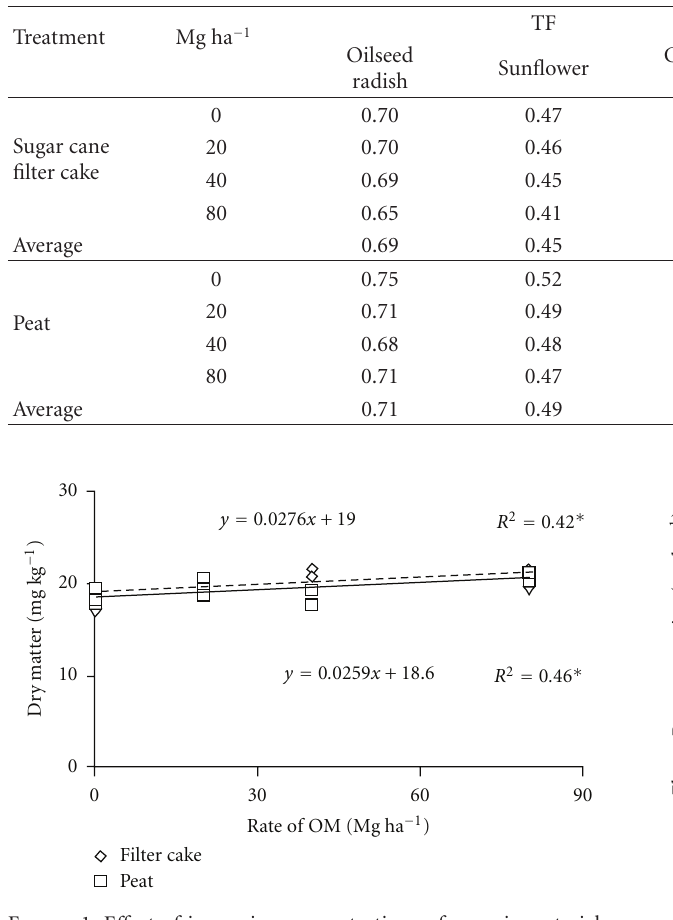
Figure 1: E ff ect of increasing concentrations of organic materials on shoot dry matter yield in castor oil plants shoots (d.w.). Signi- ficant at P < 0 . 05. Figure 2: E